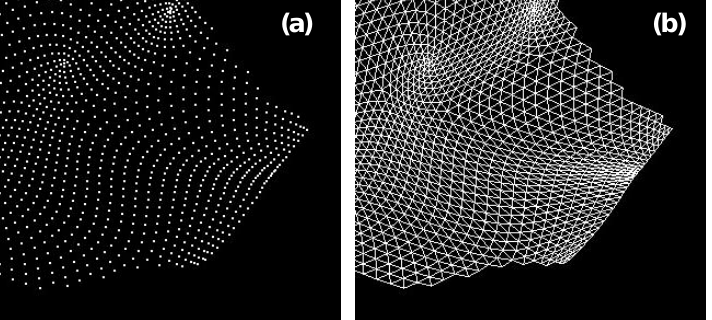
Figure 4. Close-up views of (a) a point cloud image of a certain leaf and (b) its conversion into the corresponding polygon image.